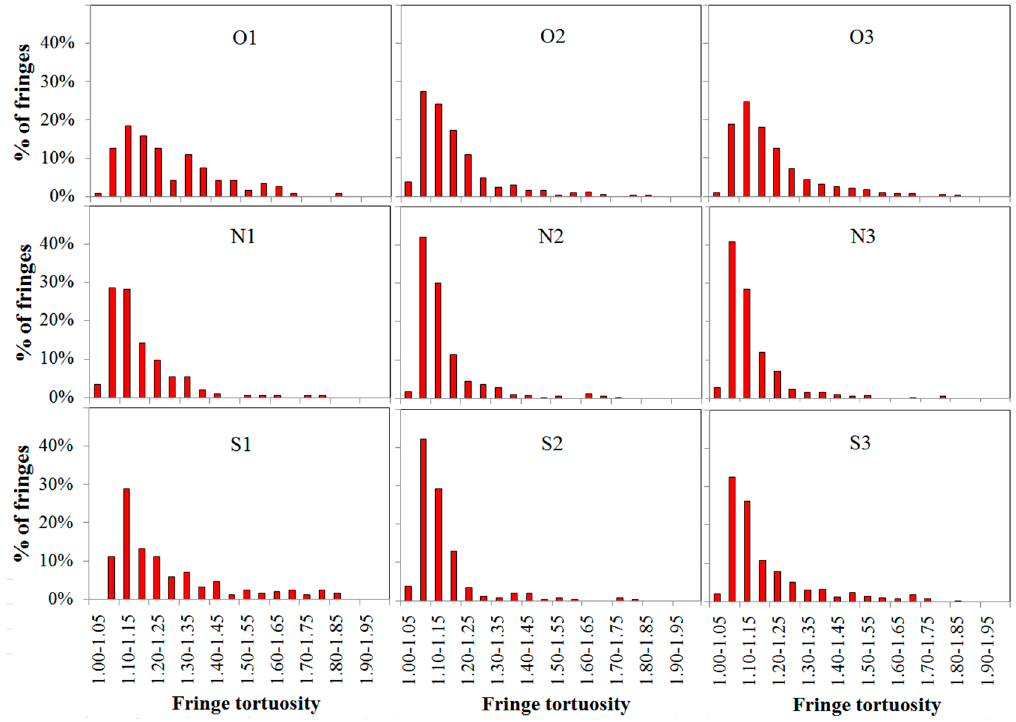
Figure 8. Fringe tortuosity histograms analyzed by the HRTEM image analysis algorithms from skeletonized images in Figure 6.